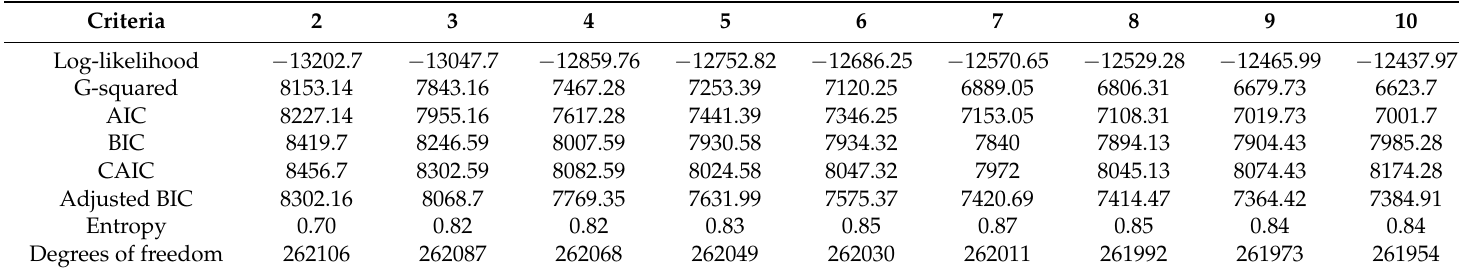
Table 2. Fit statistics for latent class models of young male fatal crash factors. AIC: Akaike Information Criterion, BIC: Bayesian Information Criterion, CAIC: Consistent Akaike Information Criterion.